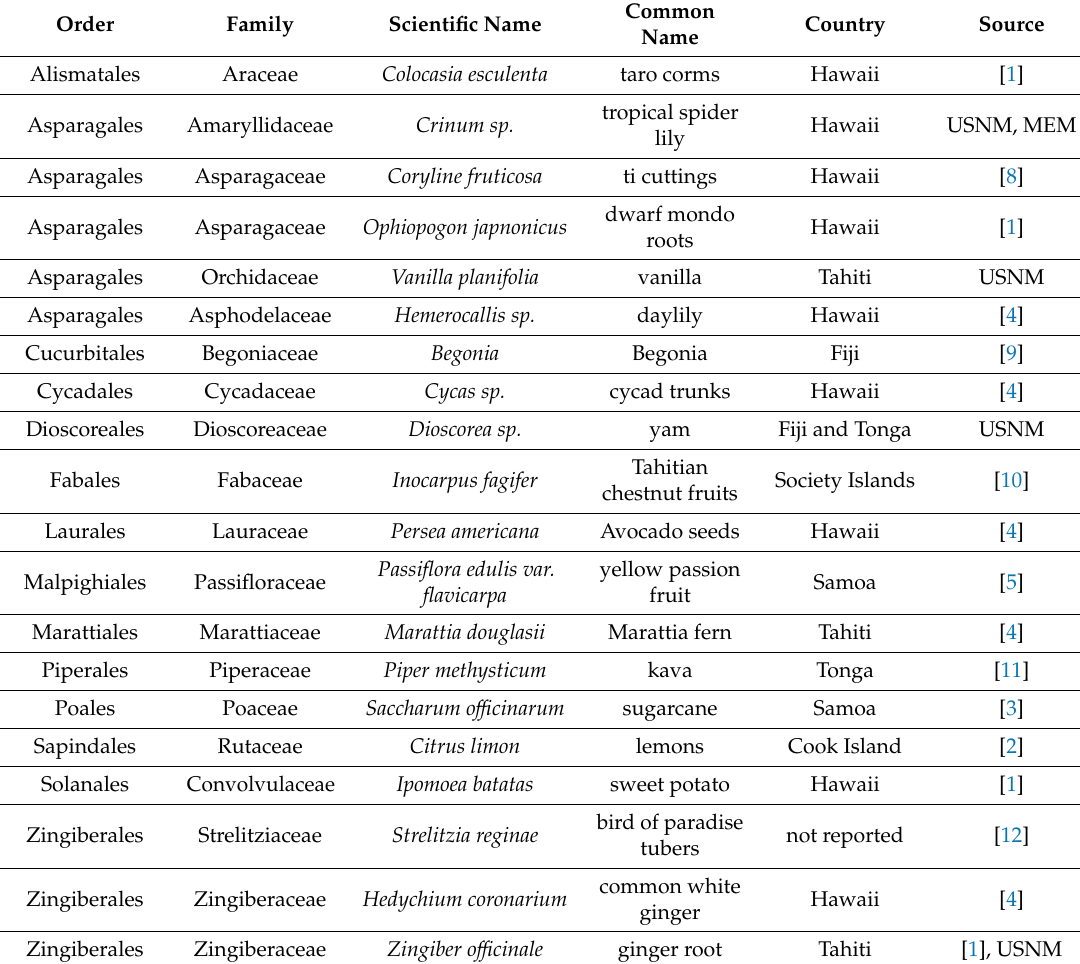
Table 1. List of host records and plant associations of E. geophilus